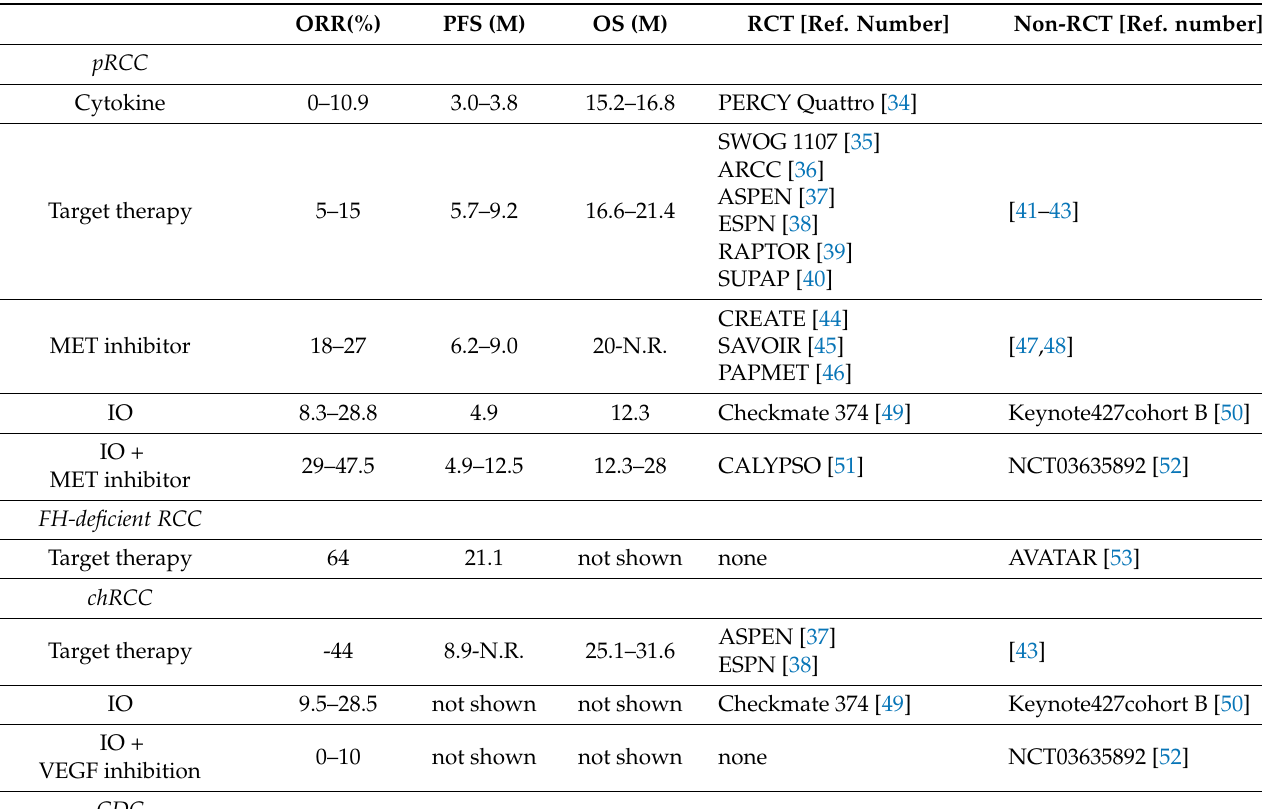
Table 3. Summary of efficacy in patients with